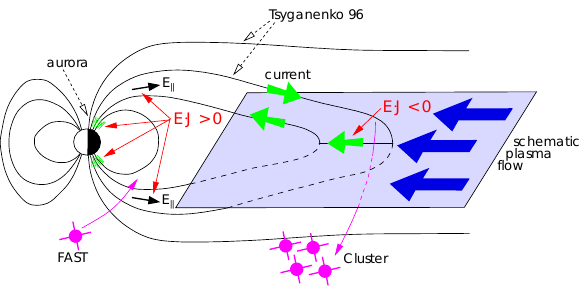
Fig. 1. A schematic sketch of the auroral current circuit. The generator region ( E · J < 0) in the magnetosphere powers the loads ( E · J > 0) in the acceleration region and the auroral ionosphere. In this article we analyze conjugate data from the Cluster fleet and the FAST spacecraft when Cluster is in the magnetosphere at an altitude of about 18Earth radii and FAST passes below the auroral acceler- ation region at an altitude of about 0.6Earth radii. Both Cluster and FAST are in the Southern Hemisphere during our event (22:00 UT, on 19 September to 01:30, on 20 September